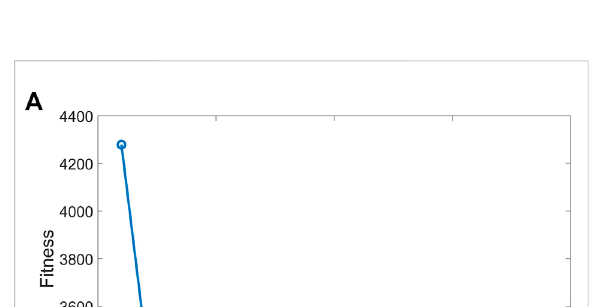
TABLE 2 Operation cost of distribution network in scenario 2 Load level/p.u Light load (0.73)